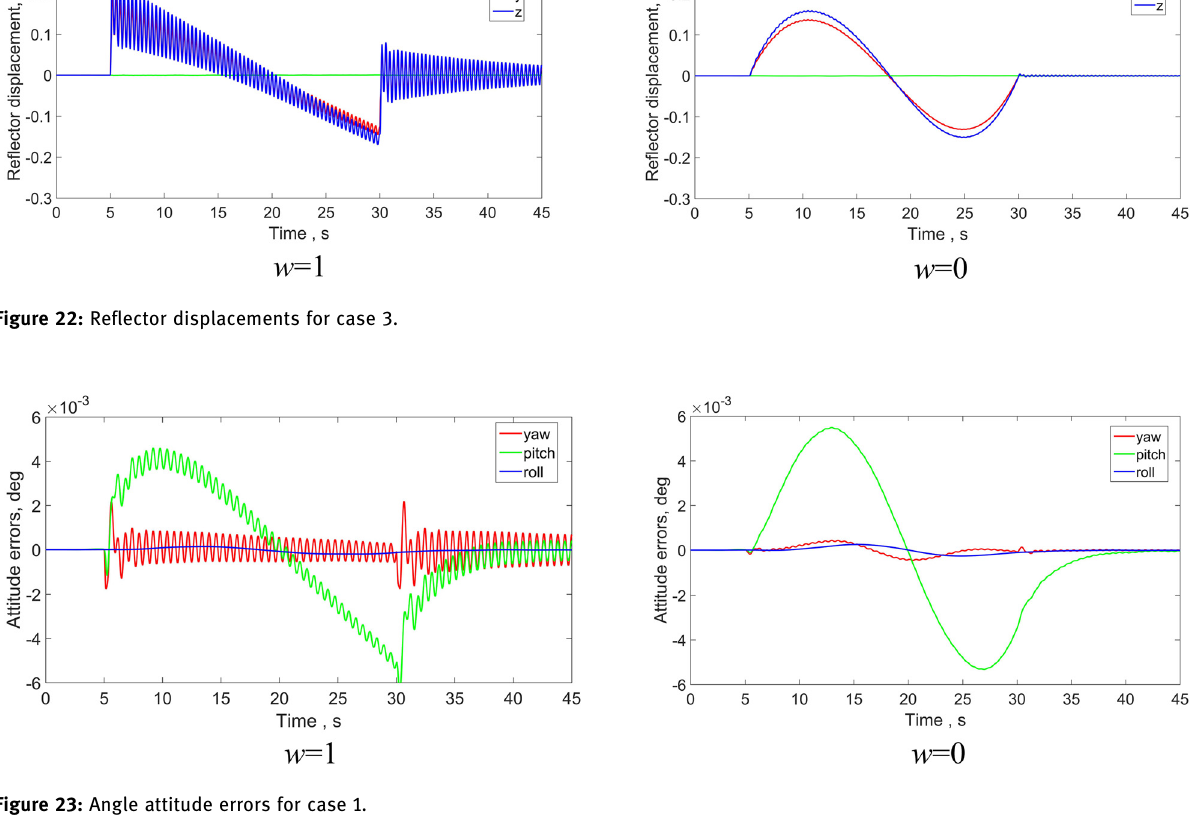
Figure 23: Angle attitude errors for case 1.